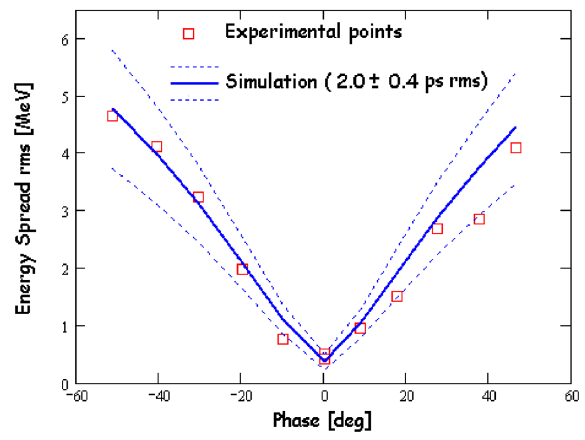
FIG. 15. (Color) Energy spread as a function of the rf phase shift for the accelerating structures and simulations for a bunch length of (cid:9) 2 : 0 (cid:4) 0 : 4 (cid:10) ps